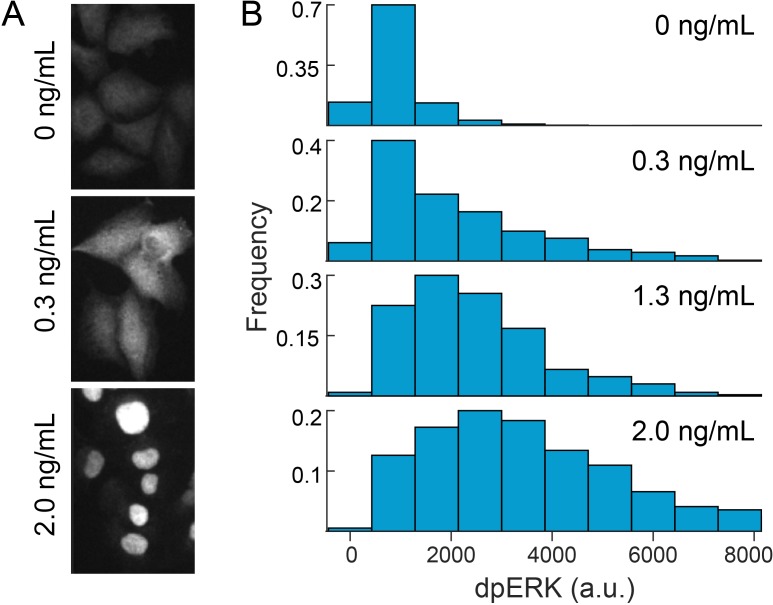
Single-cell immunofluorescence measurements show graded ERK response to EGF.In these experiments, H1299 cells were treated with varying doses of EGF for 5 min, and then fixed and analyzed for immunofluorescence against doubly phosphorylated ERK (dpERK).(A) Representative images of cells treated with the indicated doses of EGF. (B) The intensity of nuclear level of dpERK staining across individual cells. Cell nuclei were delineated using DAPI staining (for EGF doses 0, 0.3, 1.3, and 2.0 ng/mL, N = 453, 381, 373, and 413 cells, respectively).